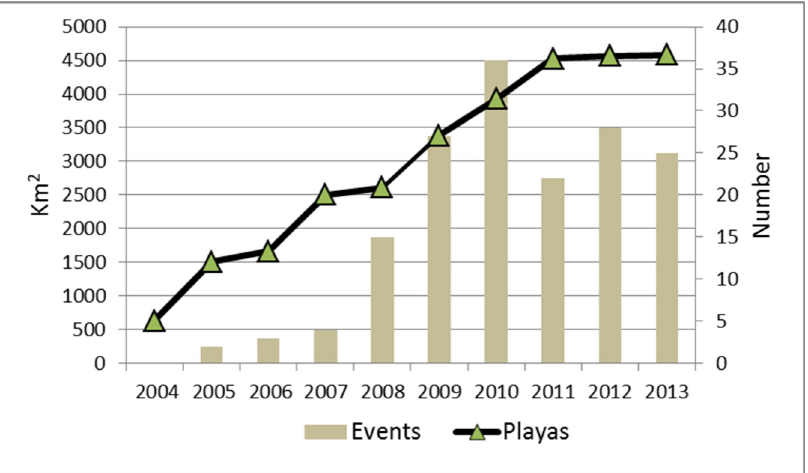
Fig 5. Area occupied by salt playas and number of salt dust events recorded in Mar Chiquita during the study period using MODIS